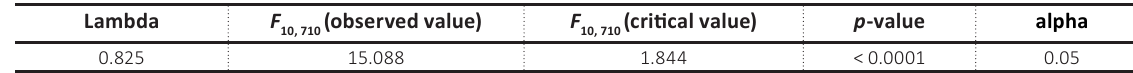
Table B7. Wilks’ Lambda test